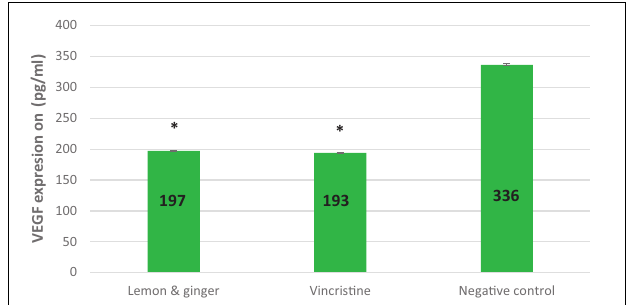
FIGURE 2 | The effect of lemon and ginger treatment on the expression of vascular endothelial growth factor (VEGF). The concentration of VEGF (pg/ml) in the MDA-MB231 cell line treated with lemon and ginger combination (3.5 mg/ml) and vincristine (0.025 mg/ml), and in untreated control cells (negative control). Each treatment was performed in triplicated. Results are shown as means (bars) SEM (lines). ∗ Significant values.